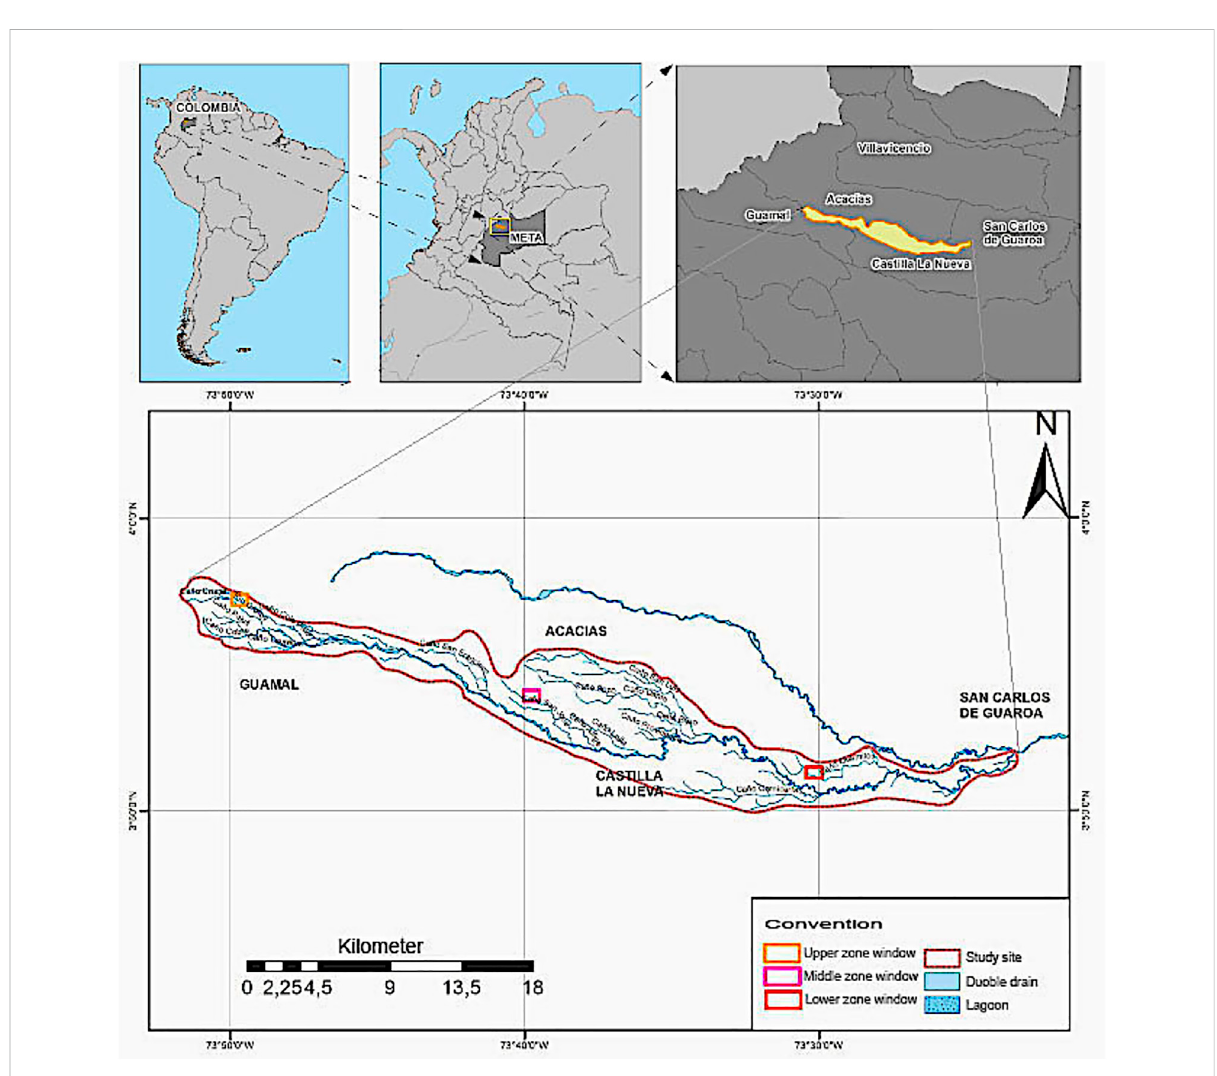
FIGURE 1 Location of the Orotoy river basin and ESPU in upper, middle and lower basin zones windows. Source: Elaborated by the